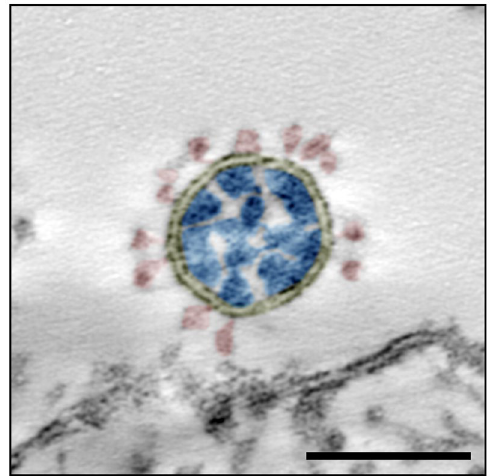
Figure 1. Transmission EM of a single virus particle of SARS-CoV-2 at the surface of a Vero cell in an ultrathin plastic section (10 summed up digital slices of an electron tomogram). The section through the virus particle shows the main ultrastructural features of the virus which were manually highlighted by color: yellow = virus- enveloping membrane, red = surface projection (spike, peplomer; trimeric S protein), blue = ribonucleoprotein (N protein and RNA). Scale bar = 100